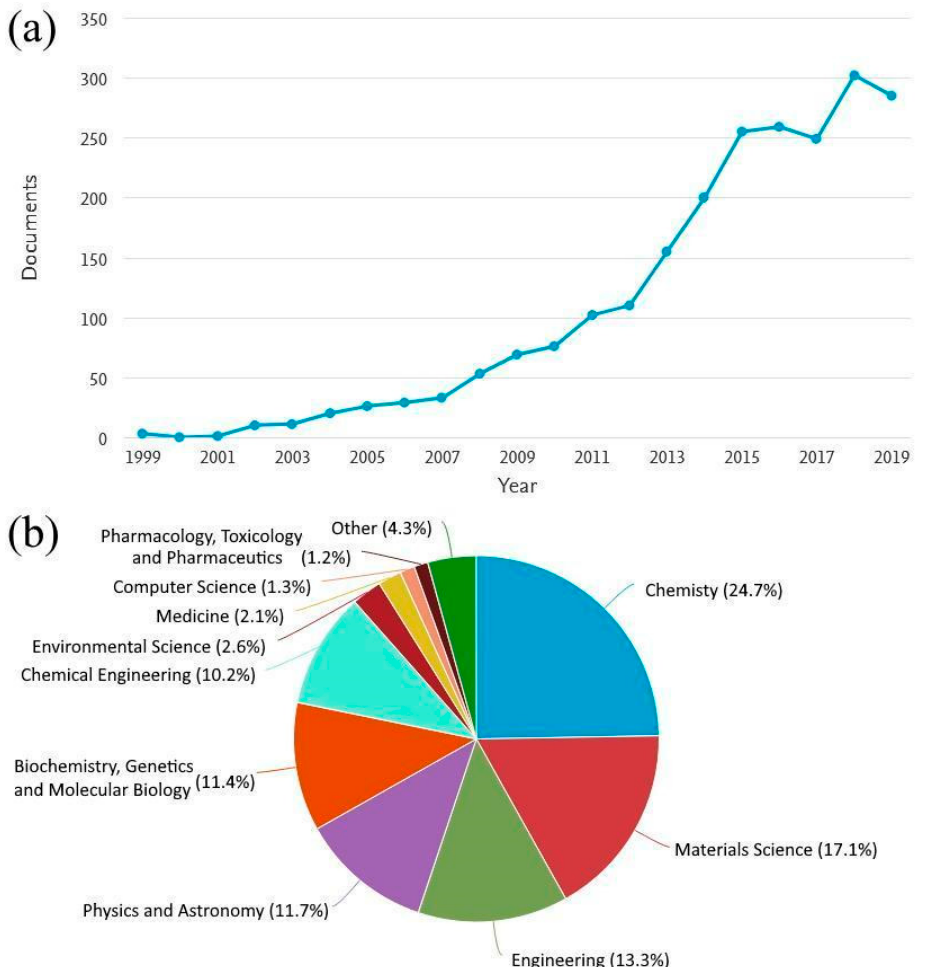
Figure 1. Analysis on the published manuscripts in the time range from 1999 to 2019: documents by year ( a ) and by subject area ( b ), respectively. Source: www.scopus.com.